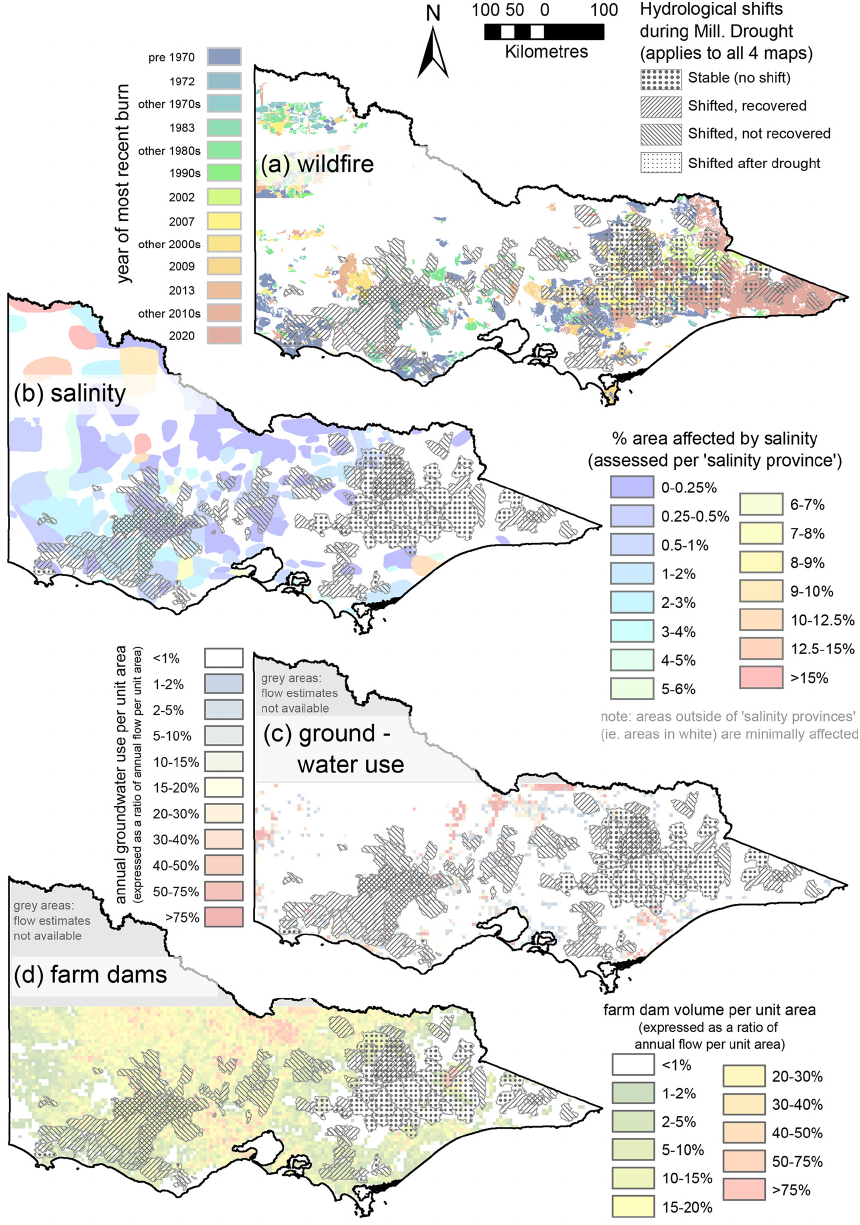
Figure 8. Similar to Fig. 7 but mapping different variables. Relativisation by annual flow for panels (c) and (d) uses areal flow estimates from Weligamage et al. (2021). Other data sources are listed in Table